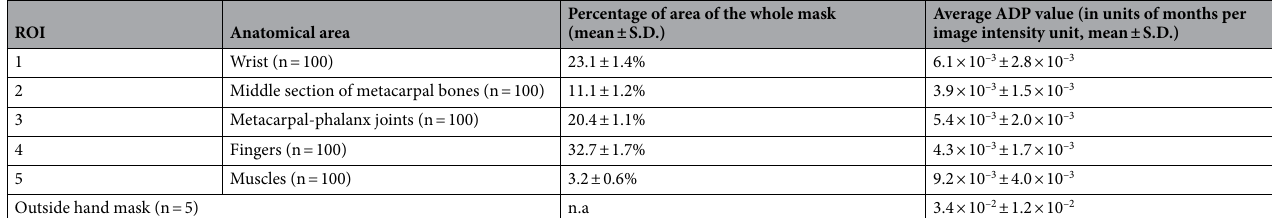
Table 1. Statistics of ROI sizes and the APD value for the test data set. APD: absolute value of the partial derivative of the predicted age with respect to input image intensity.